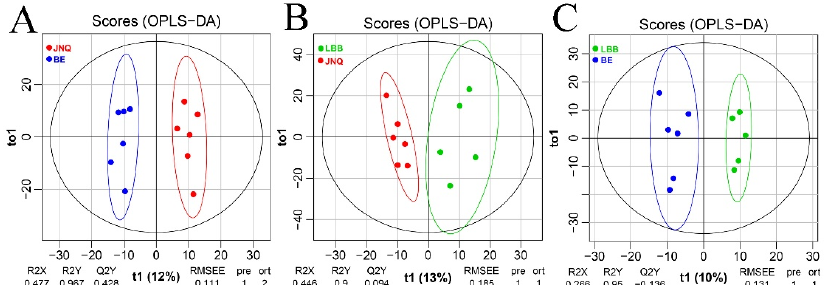
Figure 3. OPLS-DA plots showing clear metabolic differences between the meat samples. ( A ) the JNQ group (red) and BE group (blue), ( B ) the JNQ group and LBB group (green), and ( C ) the LBB group and BE group. All with 95% confidence ellipsoids.